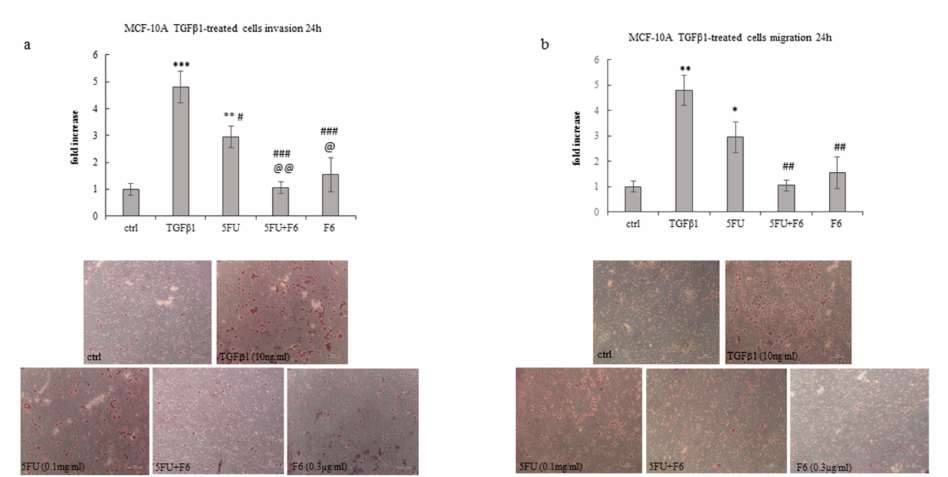
Figure 5. E ff ect of 5FU, 5FU + F6, and F6 on invasion ( a ) and migration ( b ) in MCF-10A cells. Transwell assays were performed in MCF-10A cells untreated (ctrl), and pre-treated with TGF- β 1 for 5 days. TGF- β 1 stimulated MCF-10A cells were then treated with 5FU, 5FU + F6, and F6 for 24 h. Values, expressed as fold increase of control value considered as 1, are means of three independent experiments performed in duplicate, with SD represented by vertical bars. * p < 0.05; ** p < 0.01; *** p < 0.001 versus ctrl; # p < 0.05; ## p < 0.01; ### p < 0.001 versus TGF- β 1; @ p < 0.05; @@ p < 0.01 versus 5FU by ANOVA followed by Bonferroni post-test. Images were obtained by optical microscopy, with 100 ×